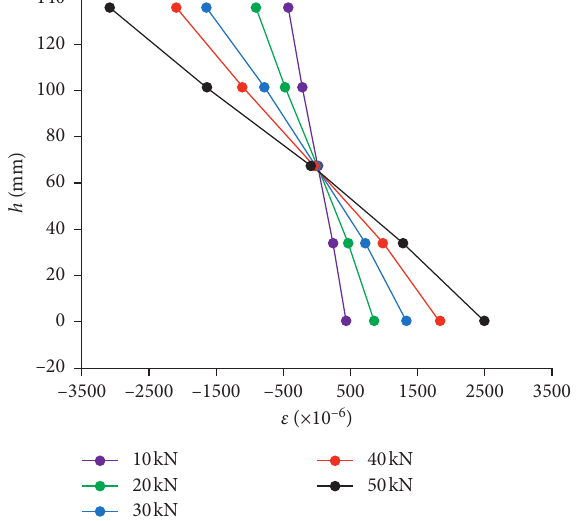
Figure 7: Strain distribution at midspan section of B-3.